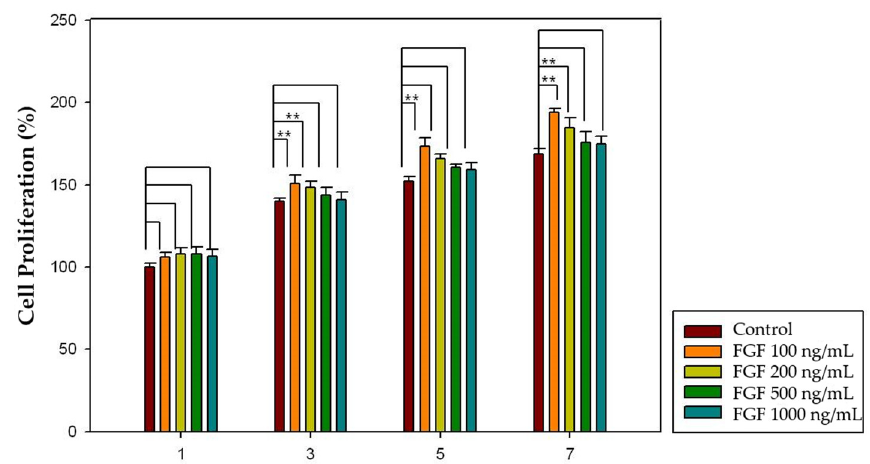
Figure 12. The effect of FGF-2 released from HA-collagen hydrogel on pulp cell proliferation. The 100 and 200 ng/mL concentrations showed significantly increased pulp cell proliferation rates in the 3-, 5-, and 7-day groups ( p < 0.05). The 100 ng/mL concentration showed significantly increased pulp cell proliferation rates in all four groups ( p < 0.05). The results are expressed as mean values ± standard deviation. ** indicates the statistically significant differences ( p < 0.05). FGF, fibroblast growth factor.